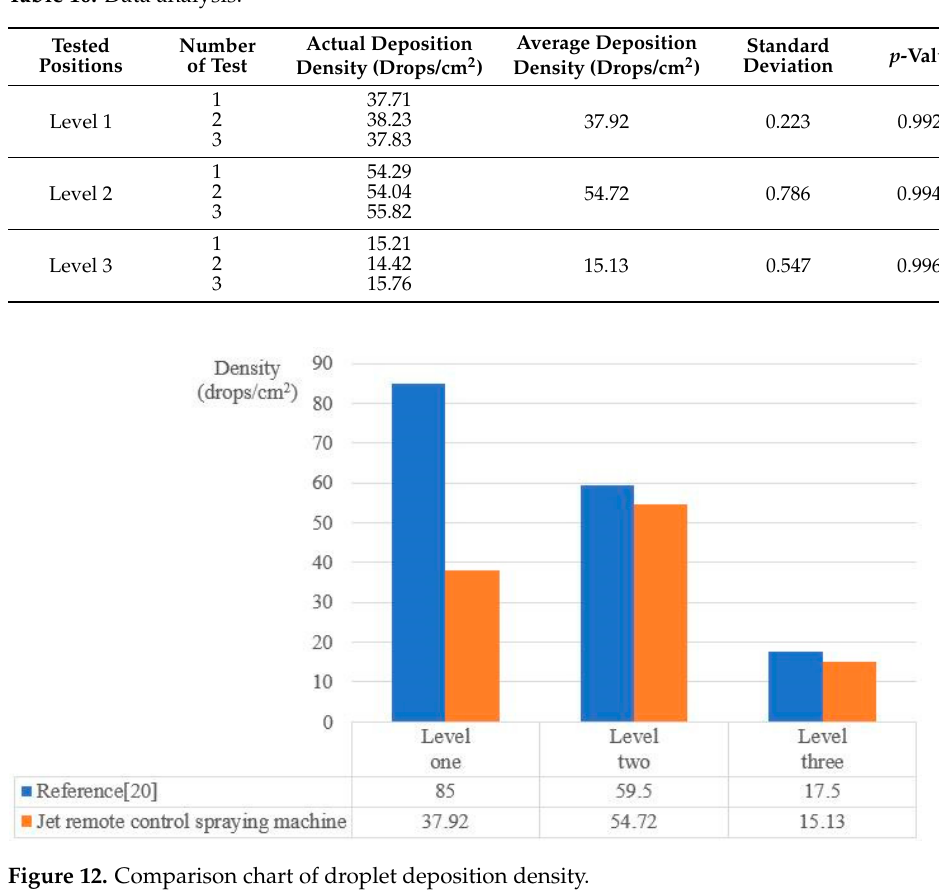
Table 10. Data analysis.